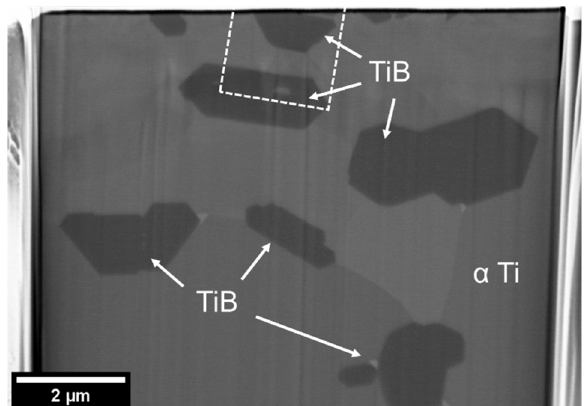
Figure 4. SE ‐ SEM image showing the focused ion beam (FIB) cross ‐ section of the AM Ti–TiB sample. Figure 4. SE-SEM image showing the focused ion beam (FIB) cross-section of the AM Ti–TiB sample.